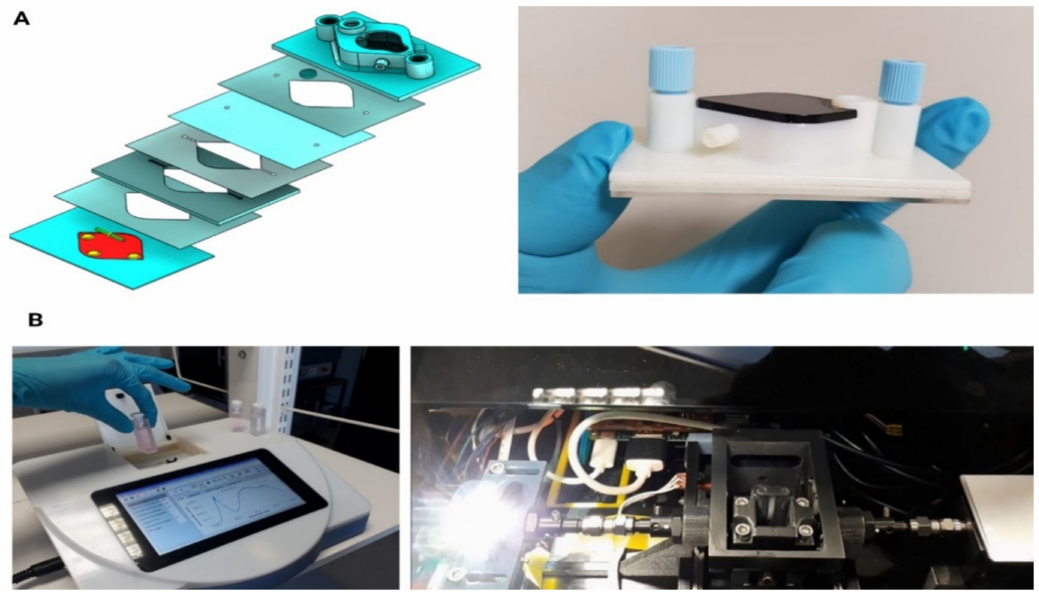
Figure 5. ( A ) Microbioreactor comprising i3DP fluidic and headspace layers joined by adhesive layers [145]. ( B ) i3DP mechanical and structural elements for cavity enhanced absorption (CEA) spectrometer